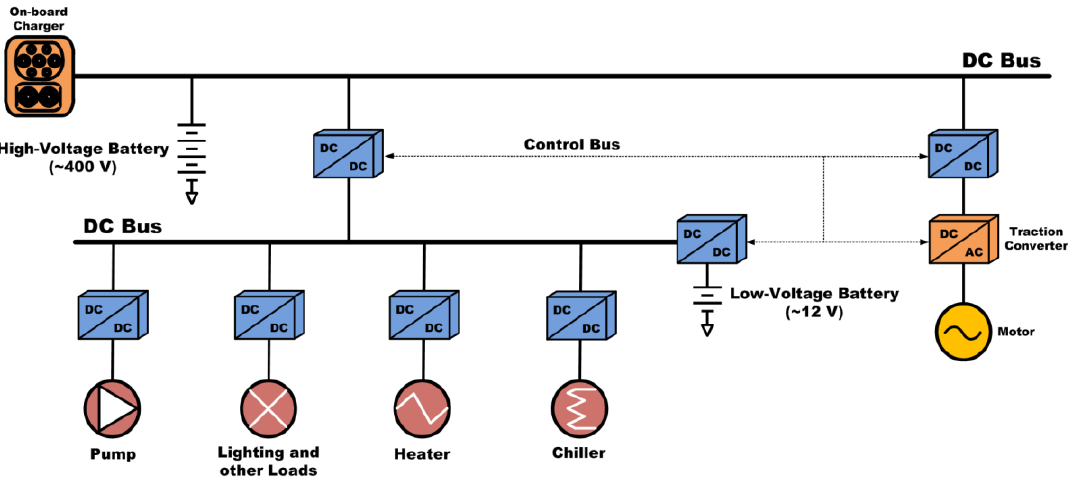
Figure 16. Scheme of an electric vehicle.